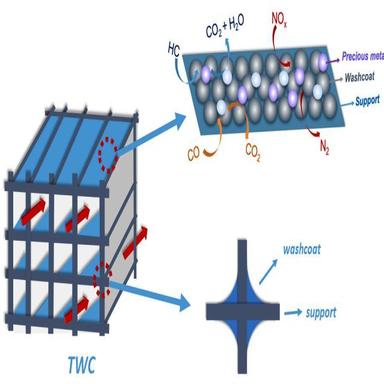
Diagram of the internal structure of an automobile exhaust catalyst.